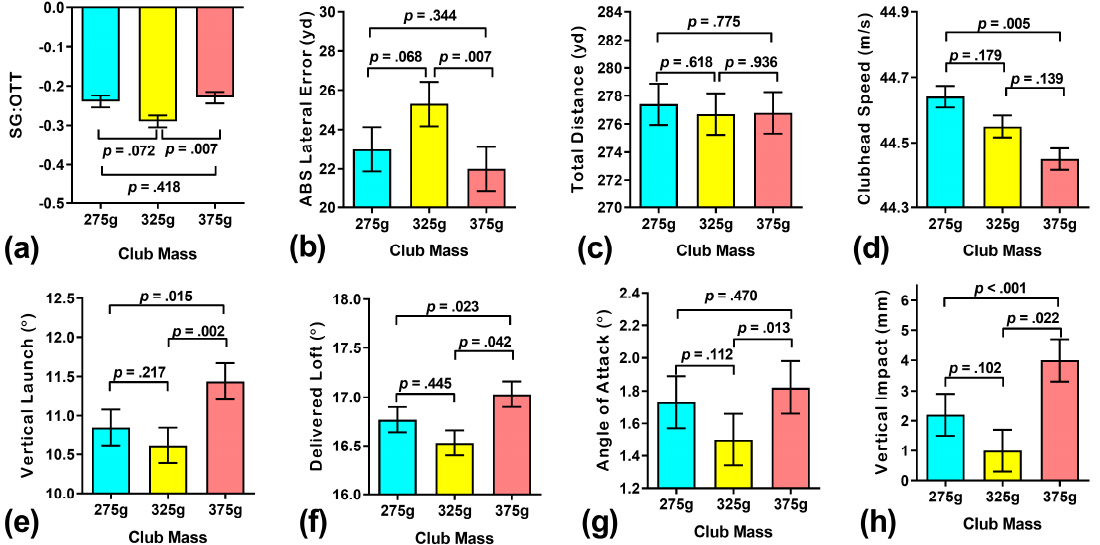
Figure 1. Influence of grip mass on various dependent variables ( a ) Strokes Gained: Off The Tee ( b ) Absolute lateral distance of the ball’s finish position from the target line ( c ) Total distance of the drive ( d ) Clubhead speed at impact ( e ) Vertical launch angle of the ball ( f ) Loft of the clubhead at the predicted instant of ball contact ( g ) Angle of attack ( h ) Vertical location of where the ball contacted the clubface relative to the center of the face. These are average values across all participants. Error bars represent 95% within-subject confidence intervals. P-values for the Bonferonni tests are also